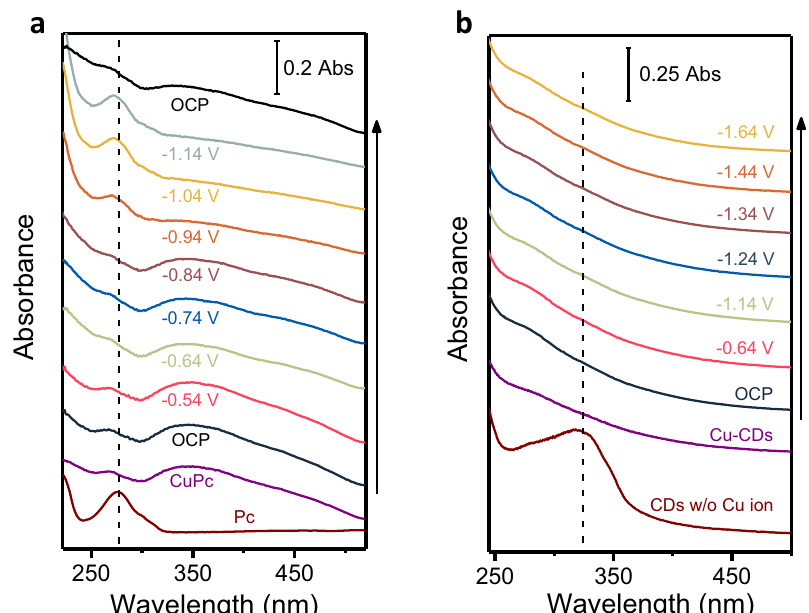
Fig. 4 In situ UV-visible measurements under electrocatalytic reaction conditions. a In situ UV-visible spectra of CuPc. b In situ UV-visible spectra of Cu- CDs. The spectra were collected with transmission mode by depositing samples on the transparent